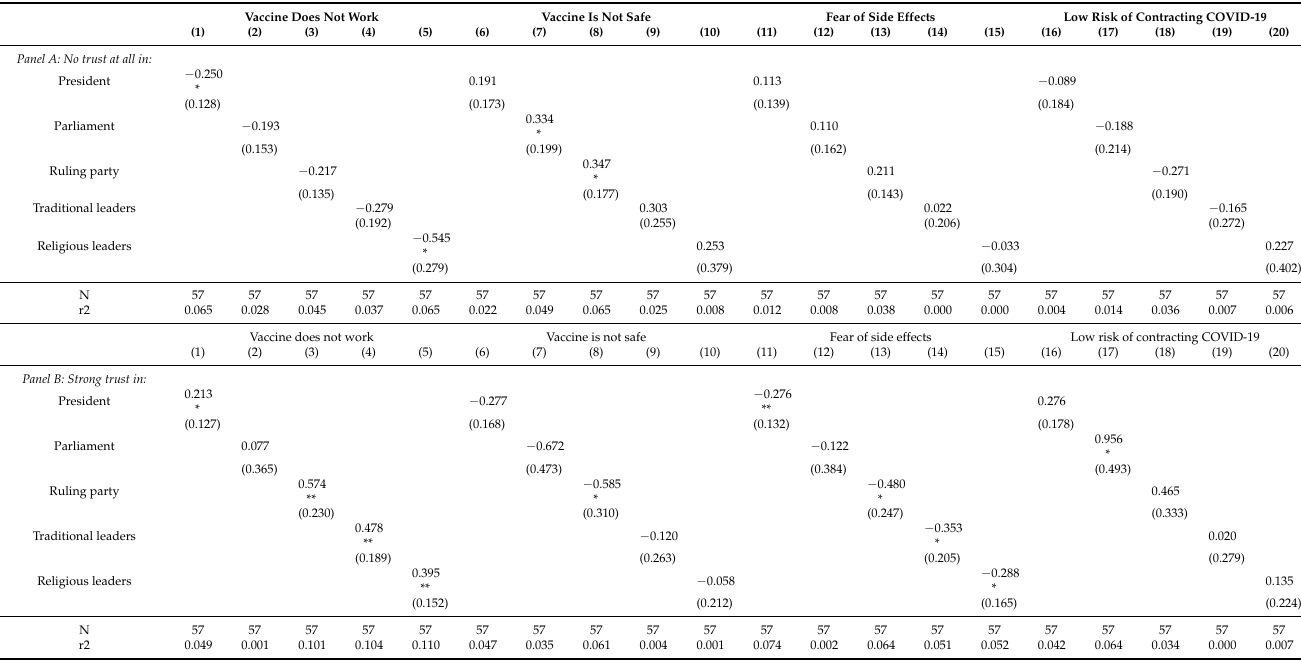
Table 2. Trust and reasons for vaccine